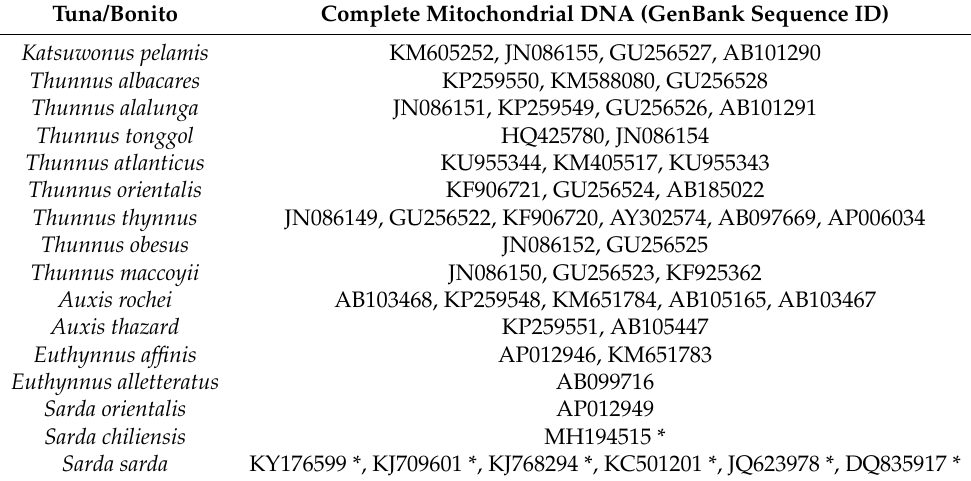
Table 4. Published complete mitochondrial DNA sequences of tunas and bonitos (GenBank; https: